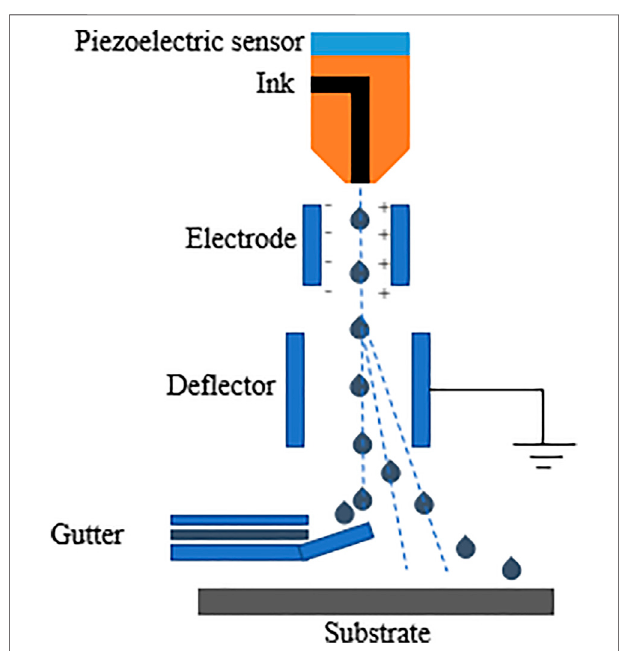
FIGURE 6 | Schematic of perovskite fi lm fabrication through inkjet printing.